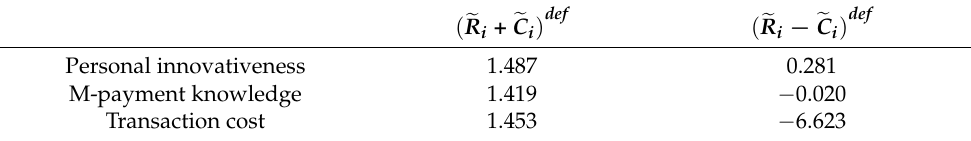
Table 5. Sum of ( (cid:101) R i + (cid:101) C i ) ual measurement.